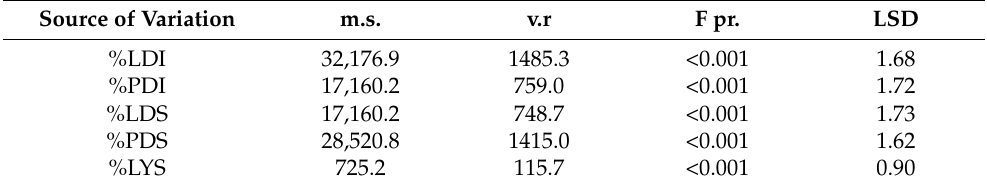
Table 1. Statistical analysis of the annual Medicago species main effects on %LDI †, %PDI, %LDS, %PDS, and %LYS.